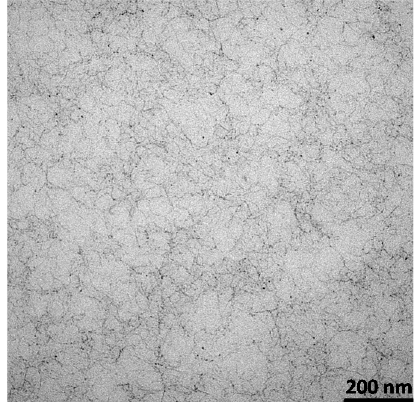
Figure 3. TEM image referring to a hydrogel obtained via the crosslinking of an alginate water solution (alginate mass fraction 2%) by means of a Ca ++ solution (5 g/L). Alginate chains are represented by the dark wires while water occupies the gray zones. Details about the hydrogel treatment for the TEM analysis are reported in